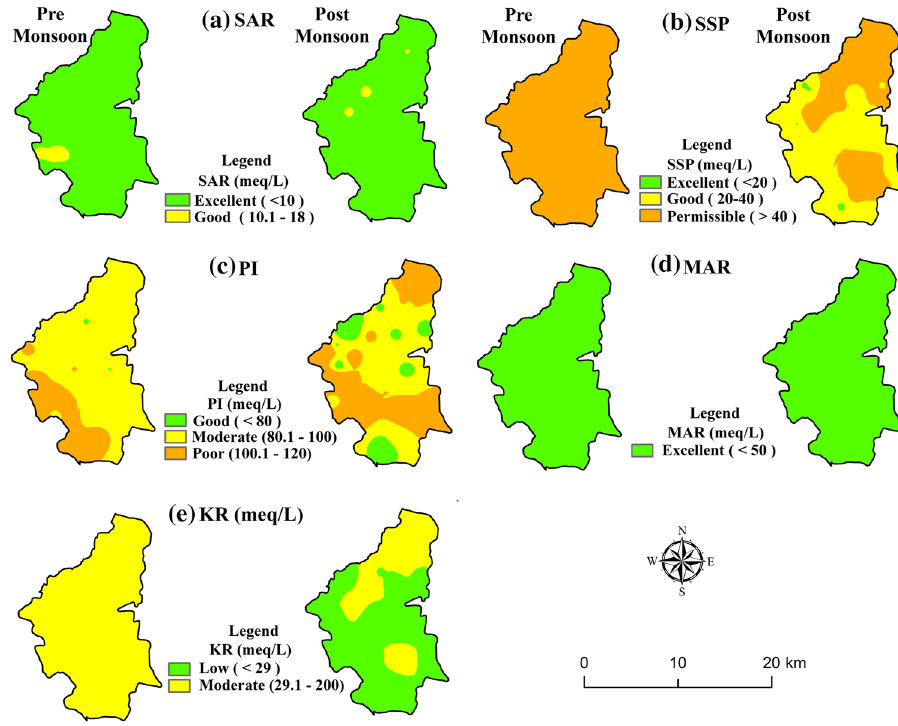
Fig. 3 Spatial distribution